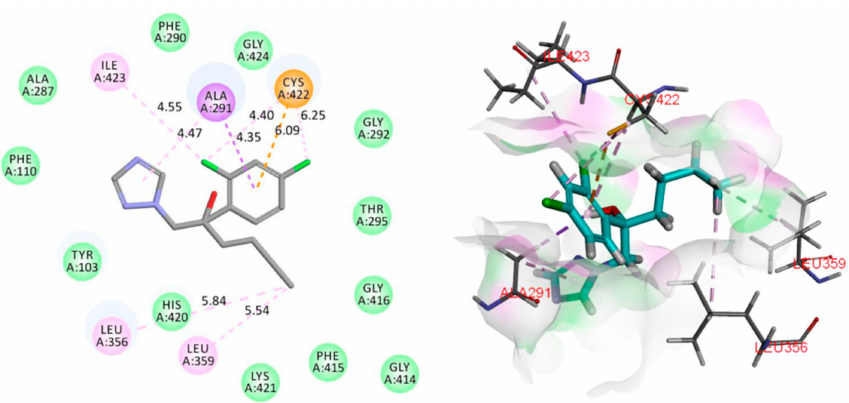
Figure 7. 2D and 3D images of hexaconazole with the target protein CYP51 (Orange dotted lines: Pi-Anion interactions, pink dotted lines: Pi-Alkyl interactions, purple dotted lines: Pi-Sigma interactions).